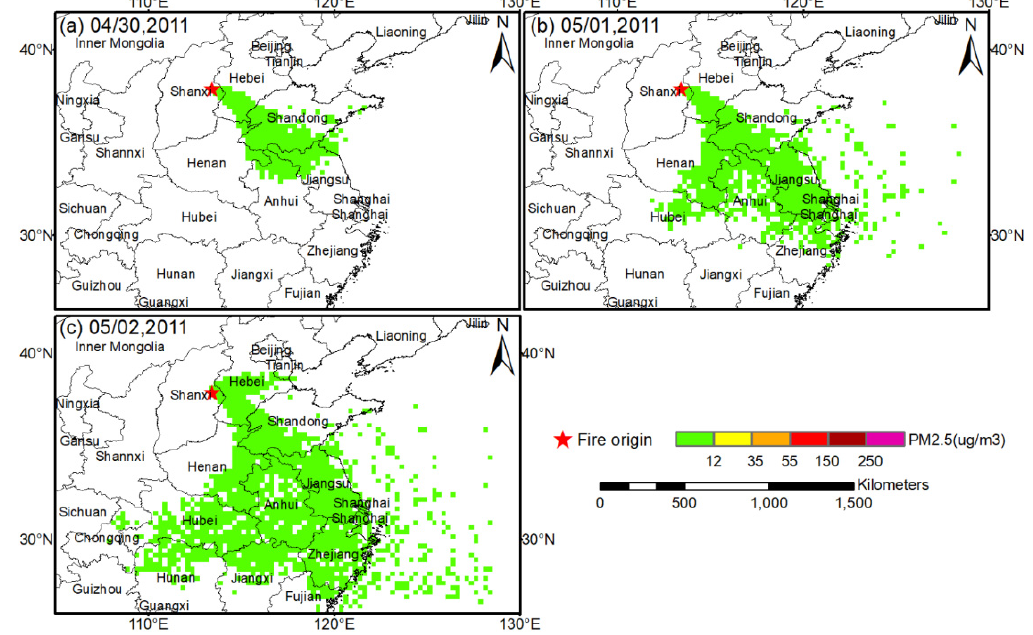
Figure A4. Same as Figure A1 except for the Yangquan fire. Panels ( a – c ) are 30 April and 1 and 2 May 2011, respectively.